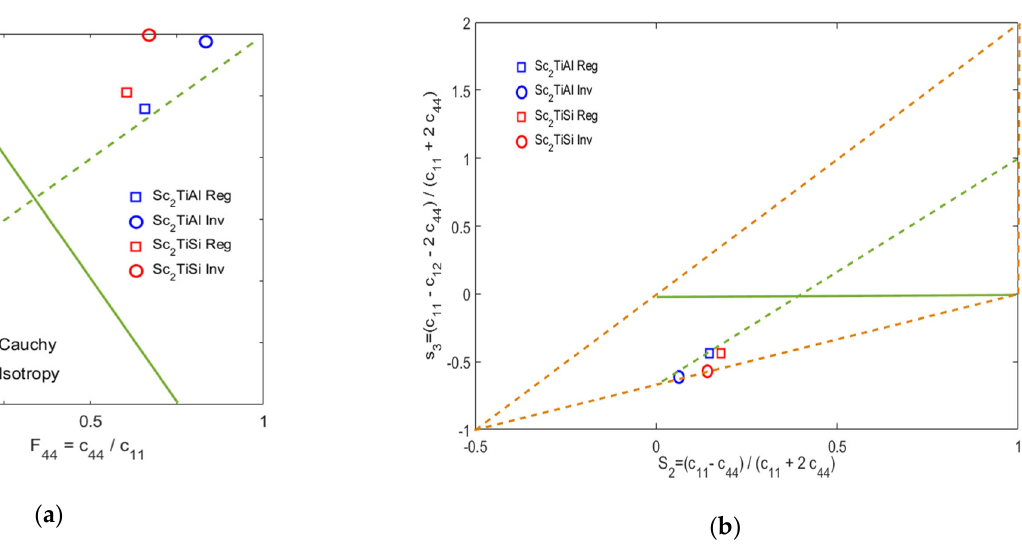
Figure 7. ( a ) Blackman’s and ( b ) Every’s diagrams. The full green line refers to the isotropic case, where A e = 1, and the dashed green line refers to the case where Cauchy pressure = 0. In Every’s diagram, the stability triangle is marked by dashed brown lines.